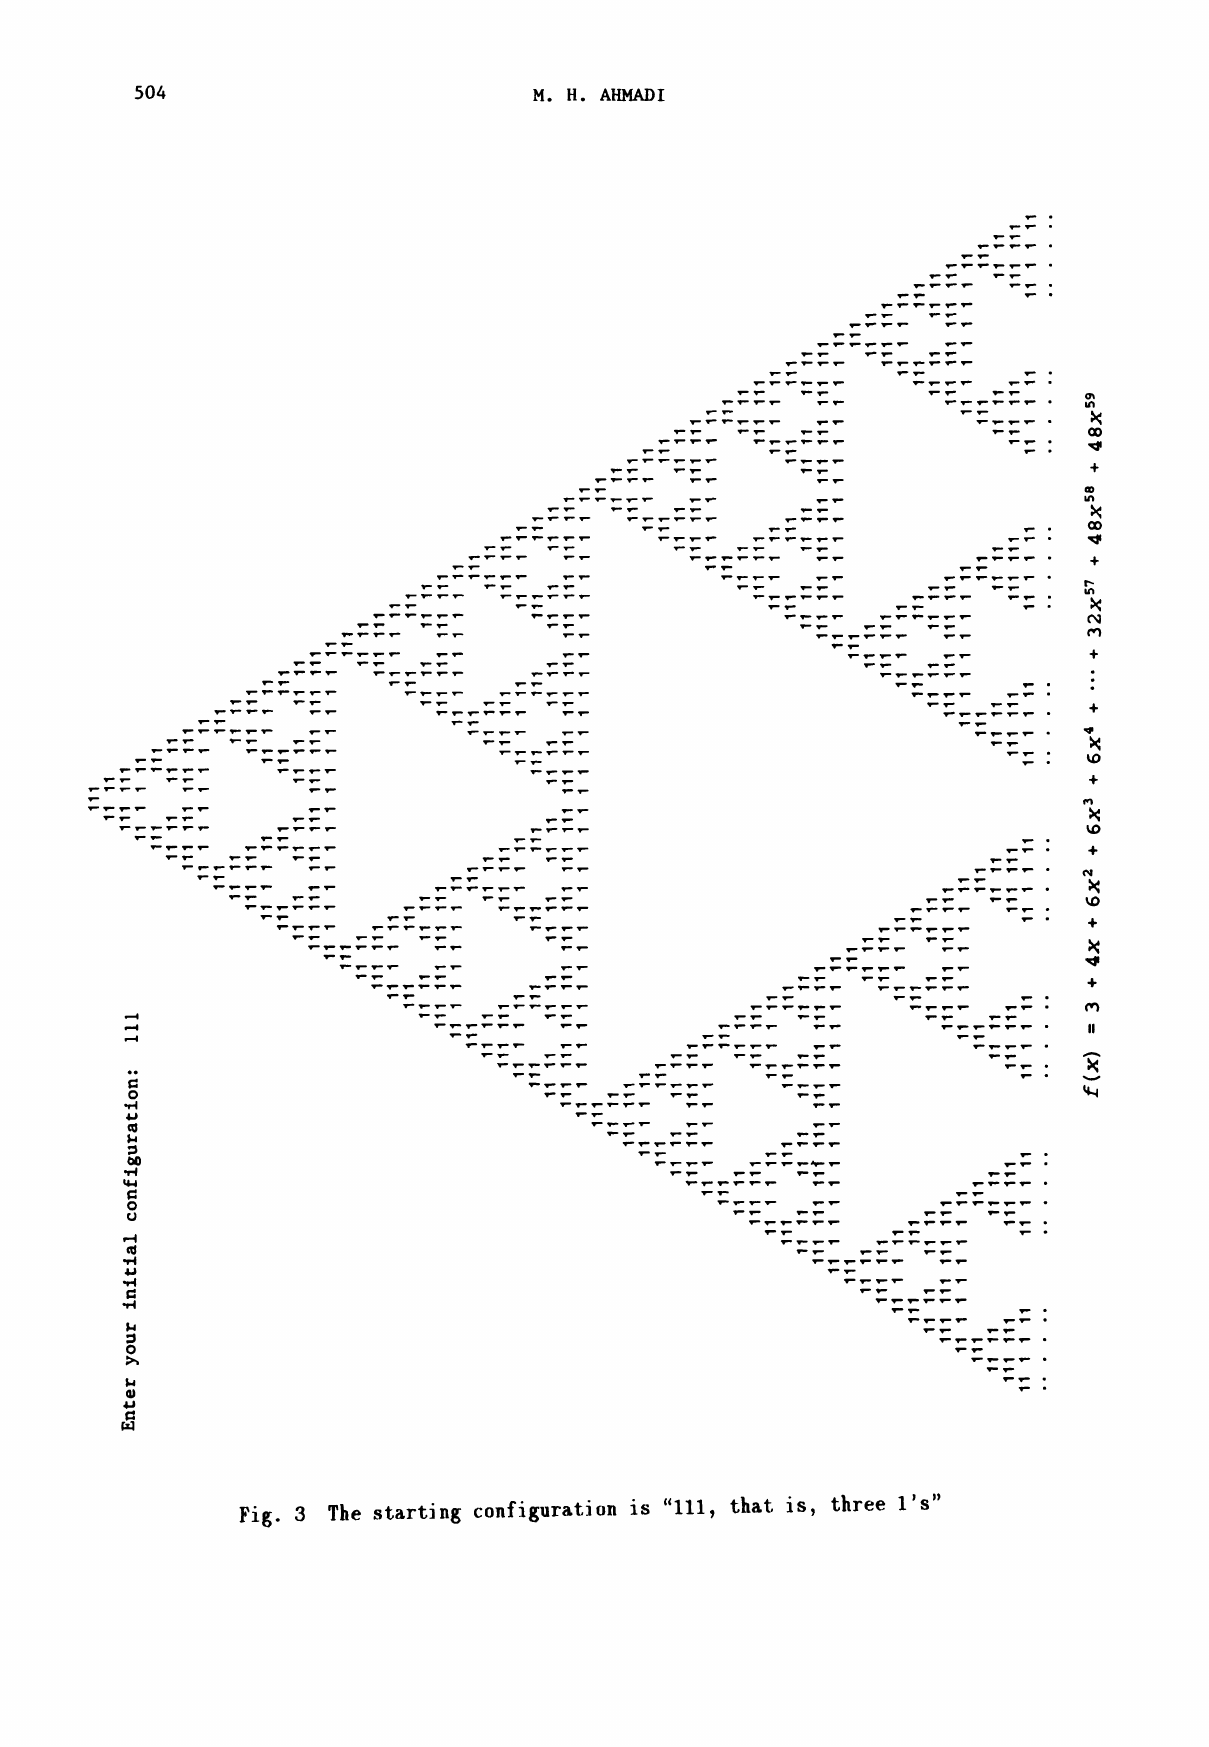
Fig. 3 The starting configuration is "111, that is,